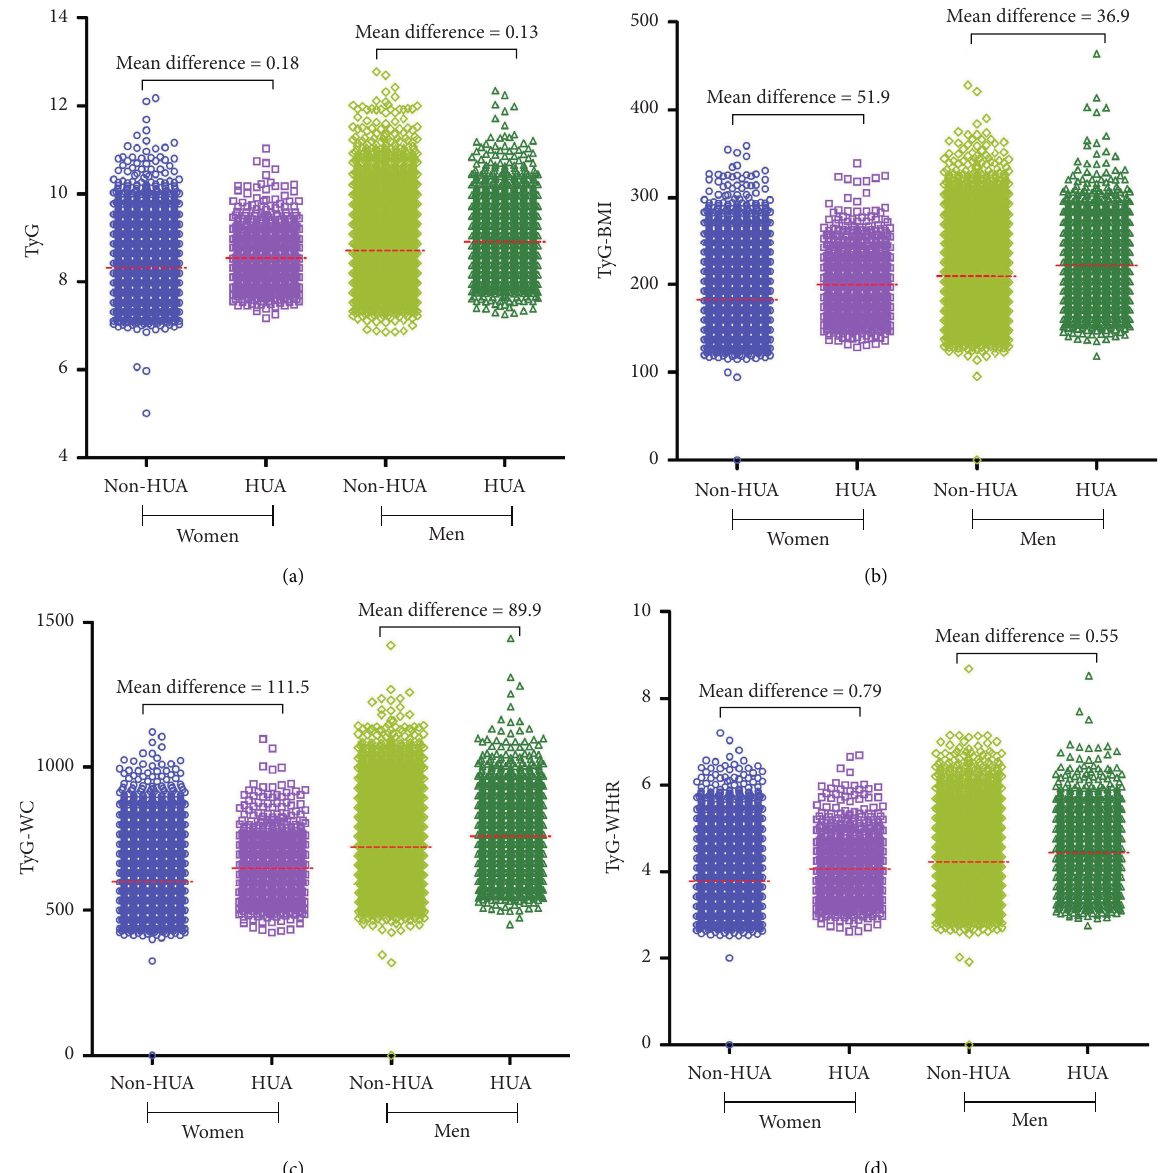
Figure 1: Gardner–Altman plots for TyG and its derivatives according to the presence and absence of HUA. The raw data of TyG and its derivatives are shown on the left axis, and the red line represents its mean value; the mean difference of variables between individual presence and absence of HUA are shown above the raw data; HUA, hyperuricemia; TyG, triglyceride and glucose index; BMI, body mass index; WC, waist circumference; WHtR, waist-to-height